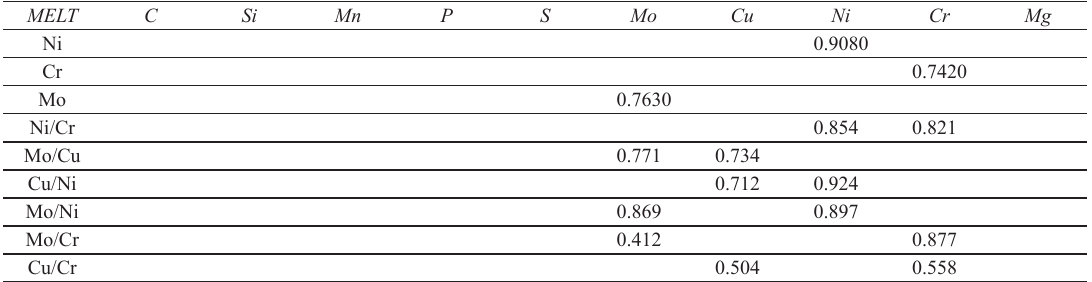
Table 1. Chemical compositions of ductile cast iron (wt pct).